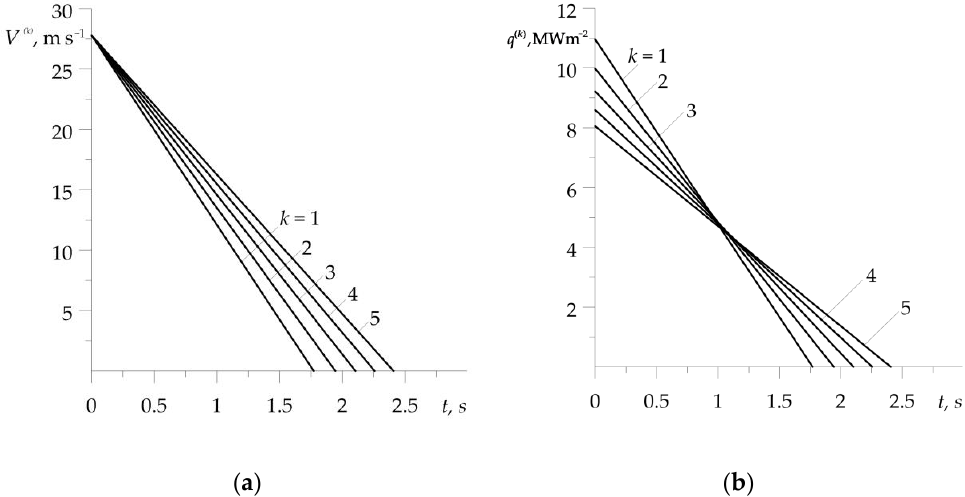
Figure 3. Evolutions of the: ( a ) velocity; ( b ) specific friction power, during each of the five braking applications.